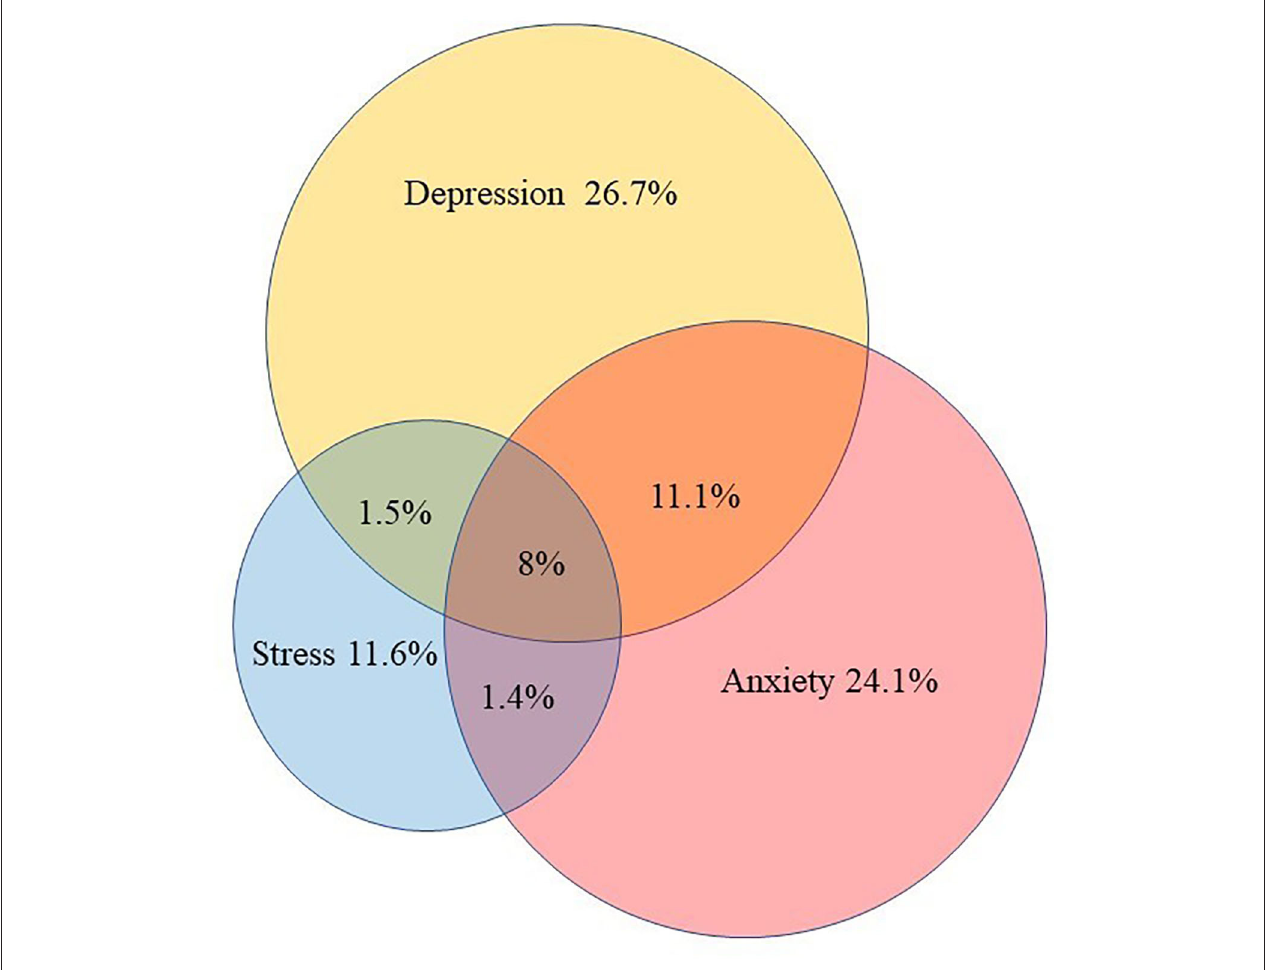
FIGURE 1 | Prevalence of probable depressive, anxious and stress symptoms. Normal participant, 66.32% (2509), either symptoms of depression, anxiety or stress 33.68% (1274). Depressive symptom, 26.7% (1011); anxious symptom, 24.1% (913); stress symptom, 11.6% (416); depressive and anxious symptoms alone, 11.1% (375); depressive and stress symptoms alone, 1.5% (44); anxious and stress symptoms alone, 1.4% (39); all of three symptoms, 8%